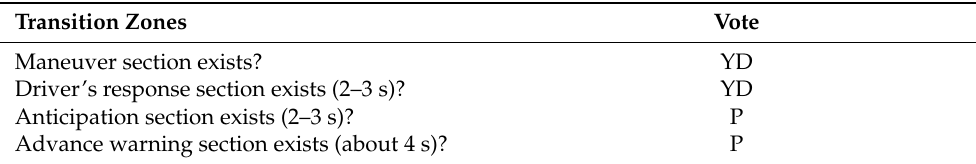
Table 5. Evaluations of the “transition zones” investigation